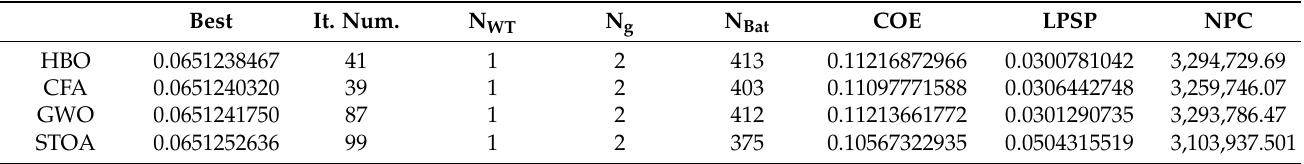
Table 8. The optimization properties for the proposed hybrid system based on using HBO, CFA, GWO and STOA for an isolated WT/Biomass/Bat.